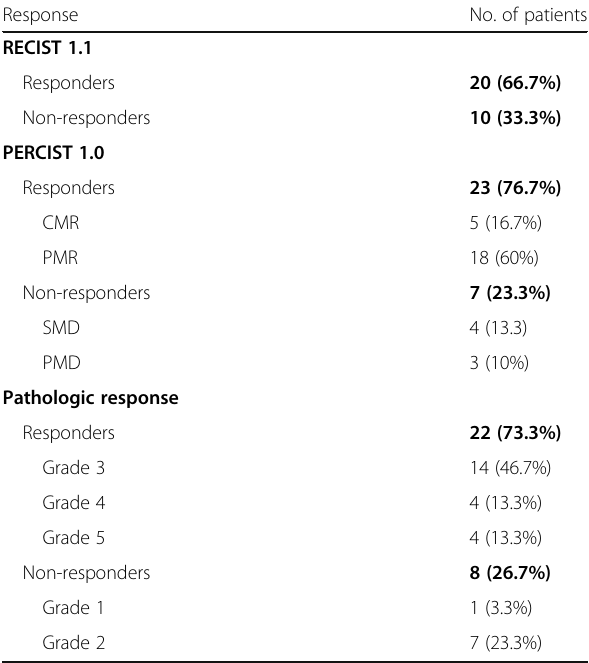
Table 3 Tumor response according to RECIST 1.1, PERCIST 1.0, and